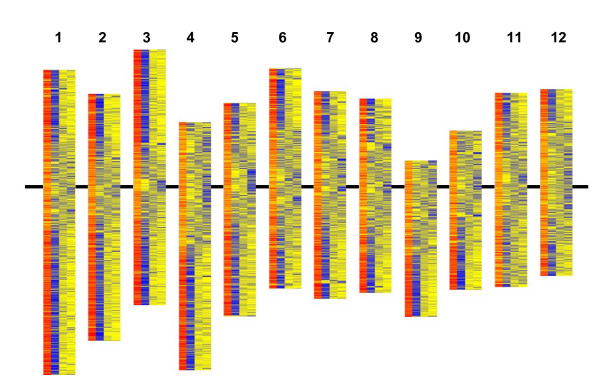
Distribution of differently-annotated TIGR rice loci on rice pseudomolecules. Linear order of differently annotated types of TIGR rice loci (TRL) on each of the rice pseudomolecules (1–12) in relation to significant MegaBLAST sequence alignments between the Os_CD database and the test databases. For each rice pseudomolecule: column 1 (red) = combined test database significant alignments; column 2 (blue) = functionally annotated TRL or expressed protein, column 3 (blue) = hypothetical protein, column 4 (blue) = retro/transposon-related sequence. Pseudomolecules are aligned along the centromere (horizontal black bar).